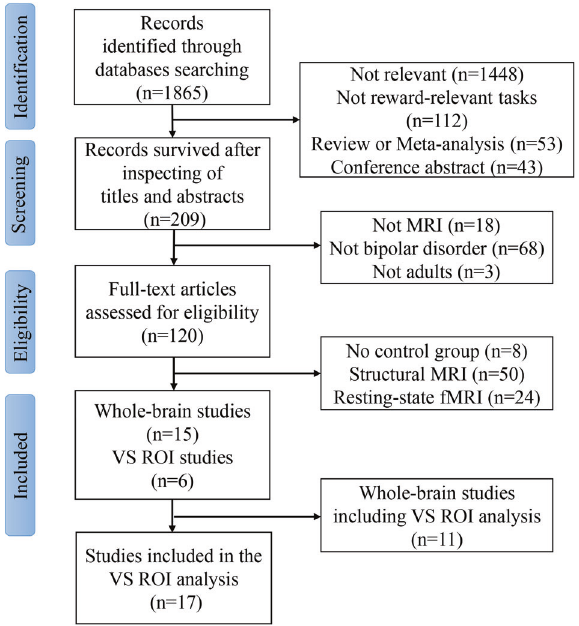
Fig. 1 Flow diagram of the literature search in this meta-analysis. ROI region of interest, VS ventral